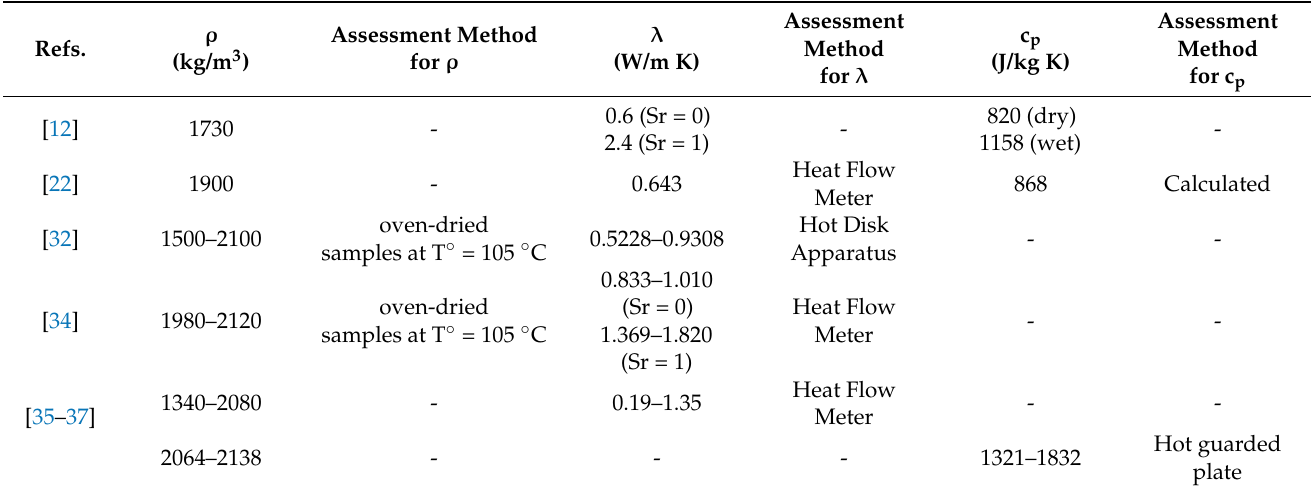
Table 1. Thermophysical properties of the rammed earth materials and assessment methods.